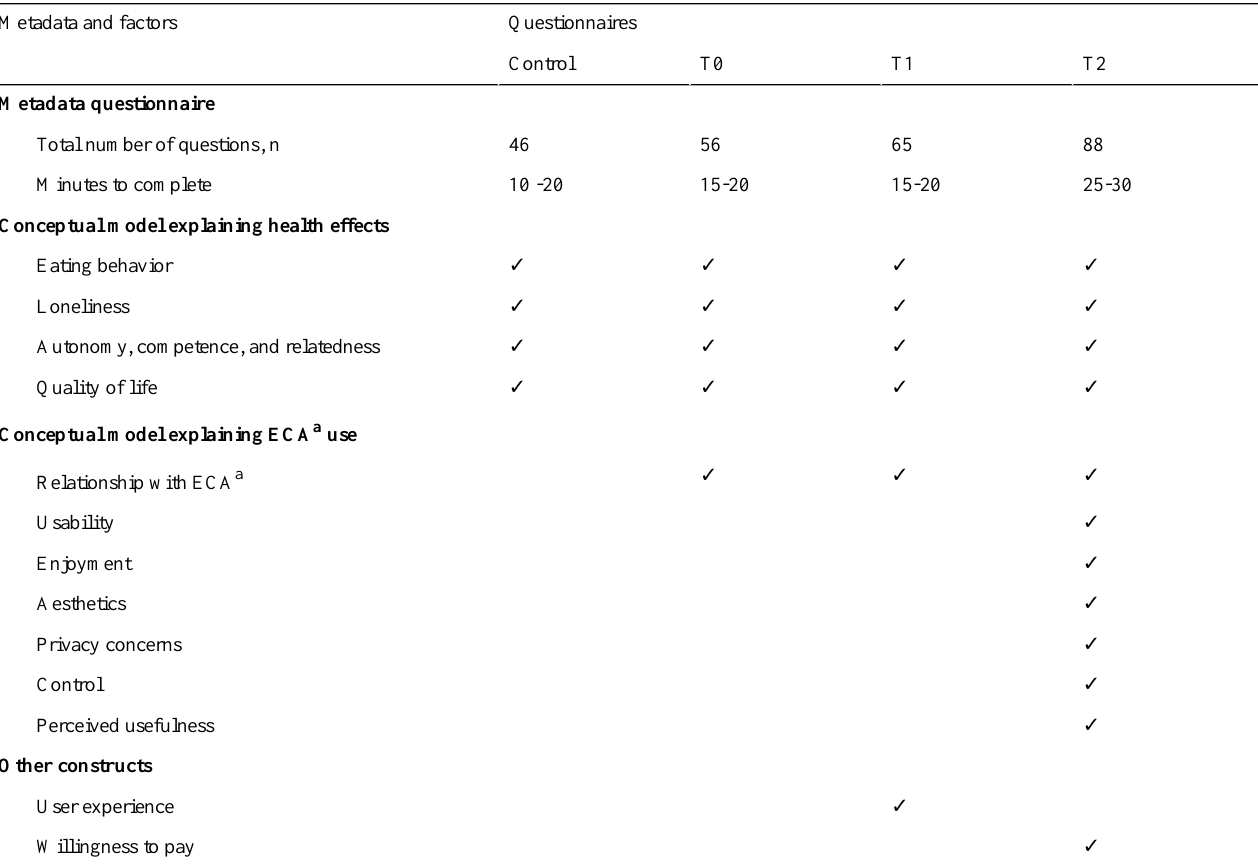
Table 1. Metadata and factors measured via questionnaires, per study phase. QuestionnairesMetadata and